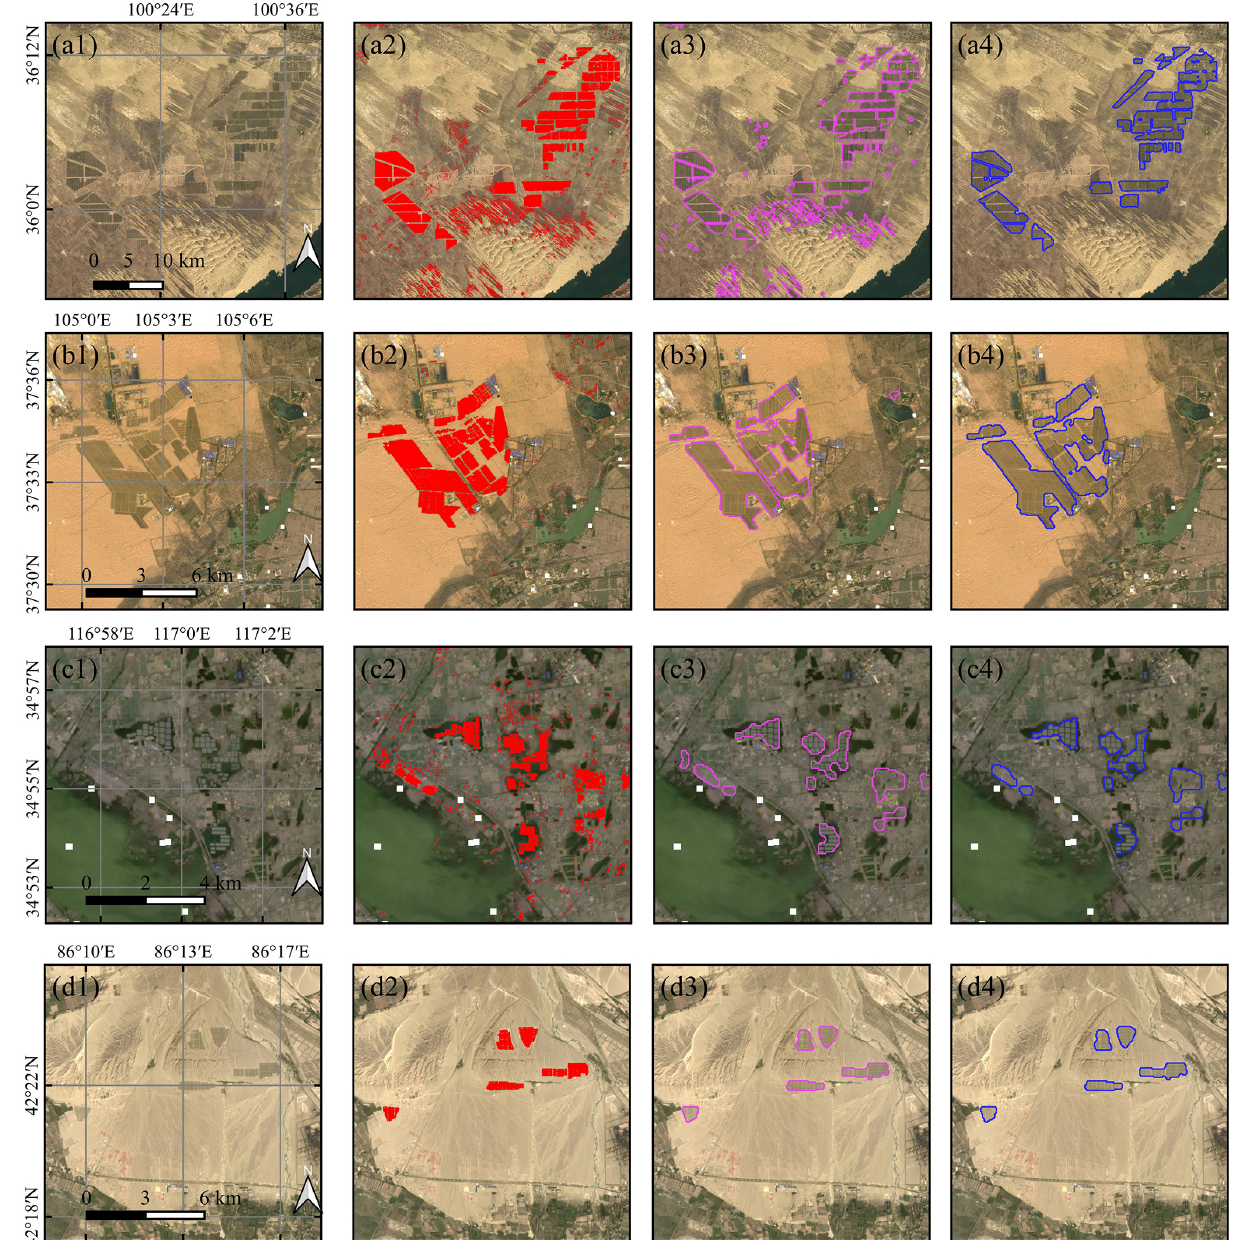
Figure 4. The examples of different steps (a1–d1) in true color of a Landsat 8 composite image in autumn 2020. (a2–d2) The random forest classification result in red. (a3–d3) The result in pink after filtering, morphological operations, and vector converting. (a4–d4) The result in blue after manually selecting and